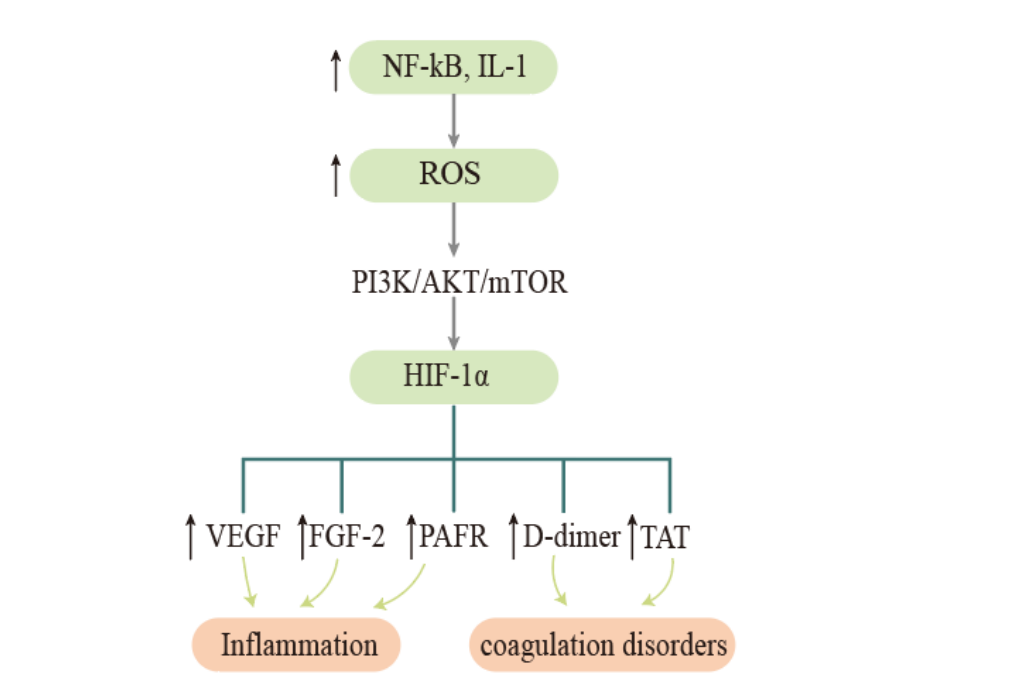
Figure 2. Oxidative stress and hypoxia lead to inflammation and coagulation dysfunction in COPD. Tobacco and bacteria stimulate inflammatory factors such as elevated respiratory NF- κB and IL -1, leading to oxidative stress in airway epithelial cells, which promotes upregulation of HIF- 1α gene expression through the PI3K/AKT/mTOR signaling pathway, and HIF- 1α entry promotes the ex- pression of factors such as VEGF, FGF-2, and TAT, inducing inflammatory responses and coagula- tion dysfunction. ROS—reactive oxygen species; VEGF—vascular endothelial growth factor; FGF-2—fibroblast growth factor; PAFR—platelet-activating factor receptor; TAT—thrombin-antithrombin